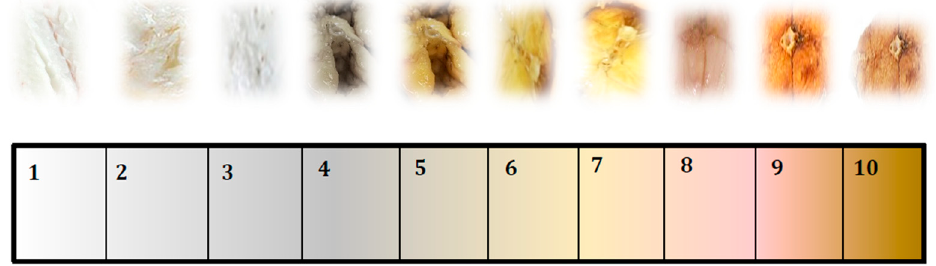
Figure 3. Colour scale prepared for rapid assessment of the colour of eel muscle (1= lighter and whitish to 10= darker and brownish).